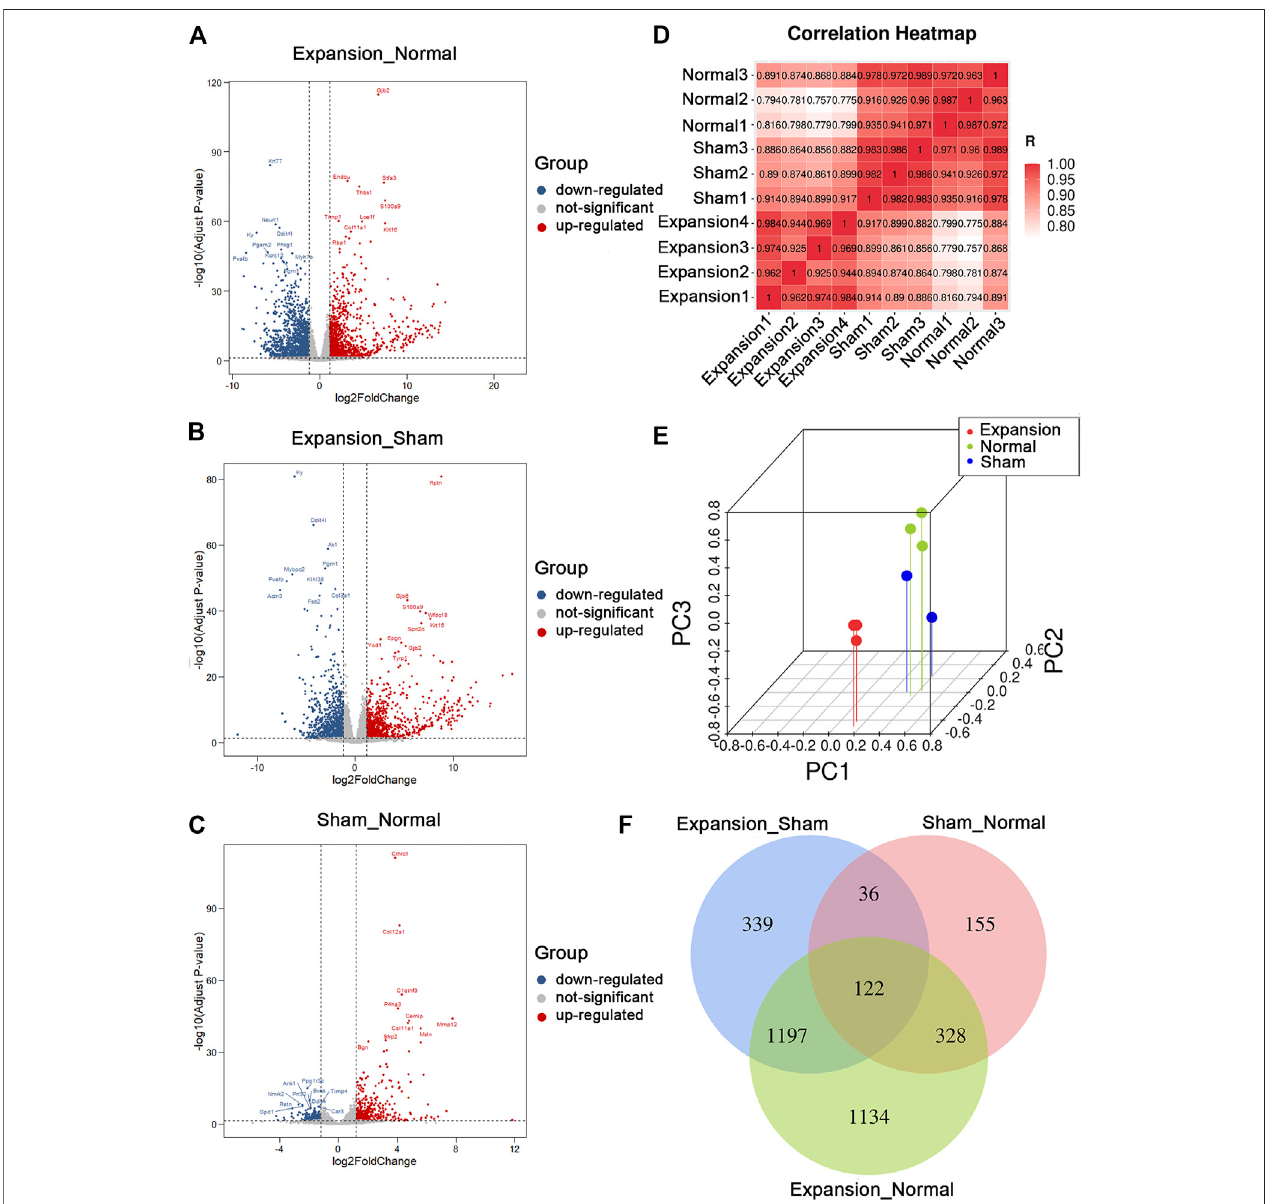
FIGURE 2 | Summary of differentially expressed genes and presentation of comprehensive similarity among the expanded group, the sham operated group, and the normal control group. (A) Analysis of differentially expressed genes between the expanded group and the normal control group by volcano mapping. (B) Analysis of differentially expressed genes between the expanded group and the sham operated group by volcano mapping. (C) Analysis of differentially expressed genes between the sham operated group and the normal control group by volcano mapping. (D) HeatMap of correlation analysis with unsupervised hierarchical clustering among the expanded, sham-operated, and normal control group. (E) 3D scatter of PCA among the expanded, sham operated, and normal control group. (F) Venn diagram showed the overlap of differentially expressed genes induced by mechanical stretch (blue + green, DEGs between the sham and normal groups were removed from thosebetweentheexpandedandnormalgroups.TheremainingDEGswerecompared withthosebetweentheexpandedandshamgroupstoobtainoverlapping1197 DEGs).